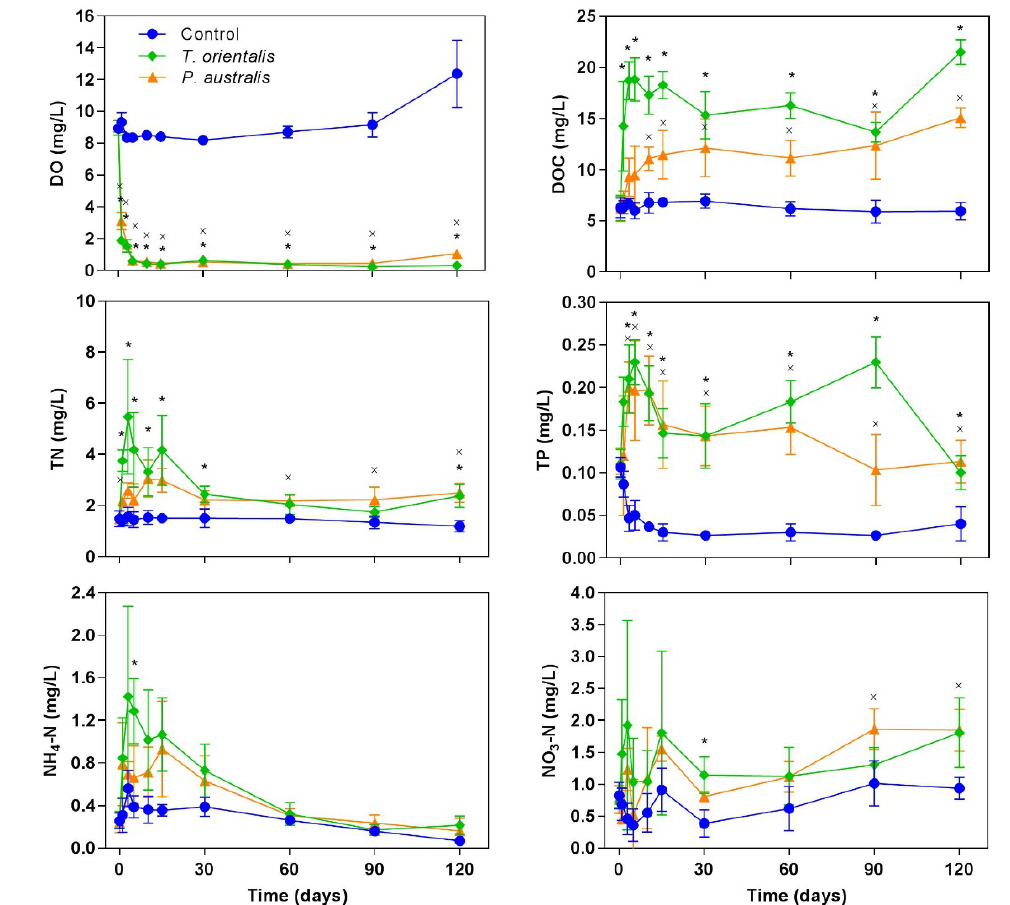
Figure 3. Dynamics of dissolved oxygen (DO), dissolved organic carbon (DOC), total nitrogen (TN), total phosphorus (TP), ammonium nitrogen (NH 4 -N), and nitrate nitrogen (NO 3 -N) in the water column during the 120-day incubation. * Significant difference between T. orientalis treatment and control, × significant difference between P. australis treatment and control (repeated measures ANOVA, post hoc Dunnett’s tests, p < 0.05).